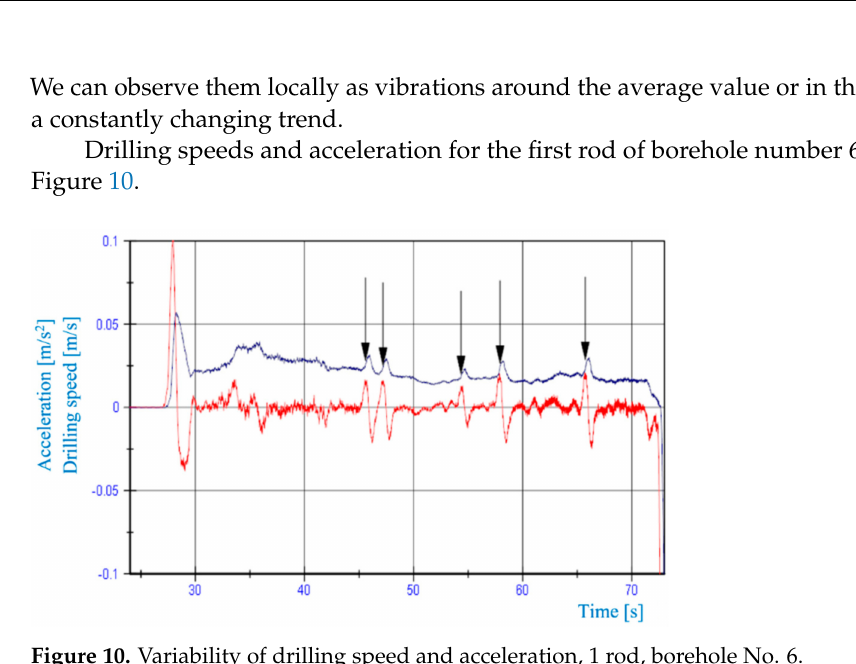
Figure 10. Variability of drilling speed and acceleration, 1 rod, borehole No. 6.